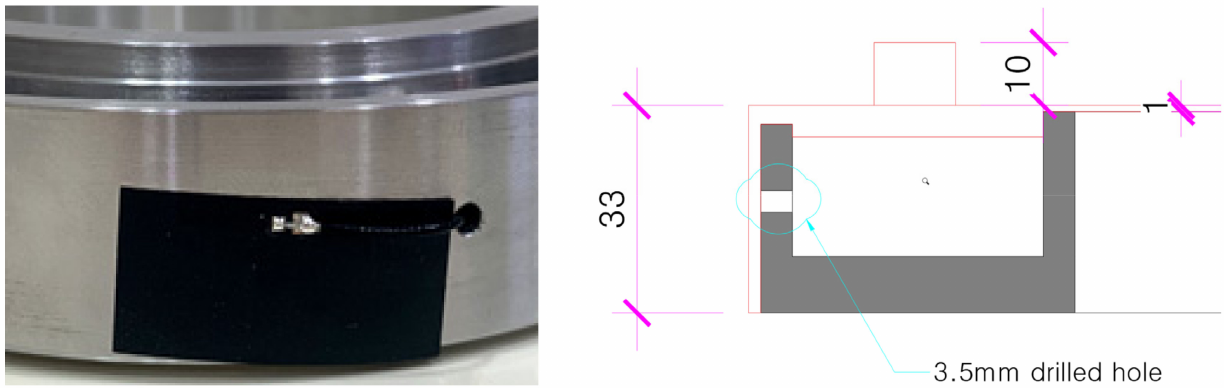
Figure 11. Installation of film